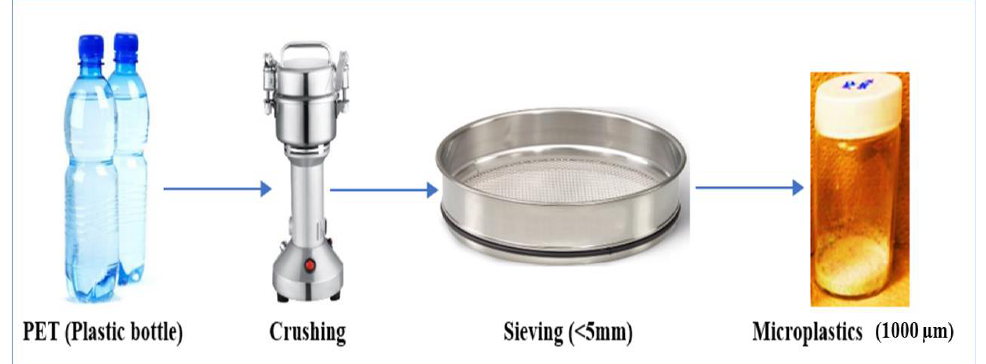
Figure 1. Preparation of PET MPs.